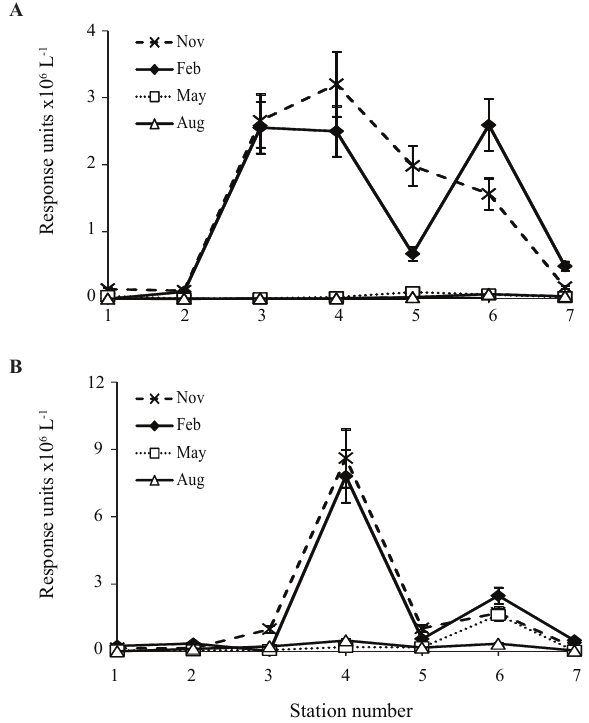
Fig. 2. The HPH crenarchaeol abundance along the sampling tran- sect in (A) surface water and (B) bottom water.